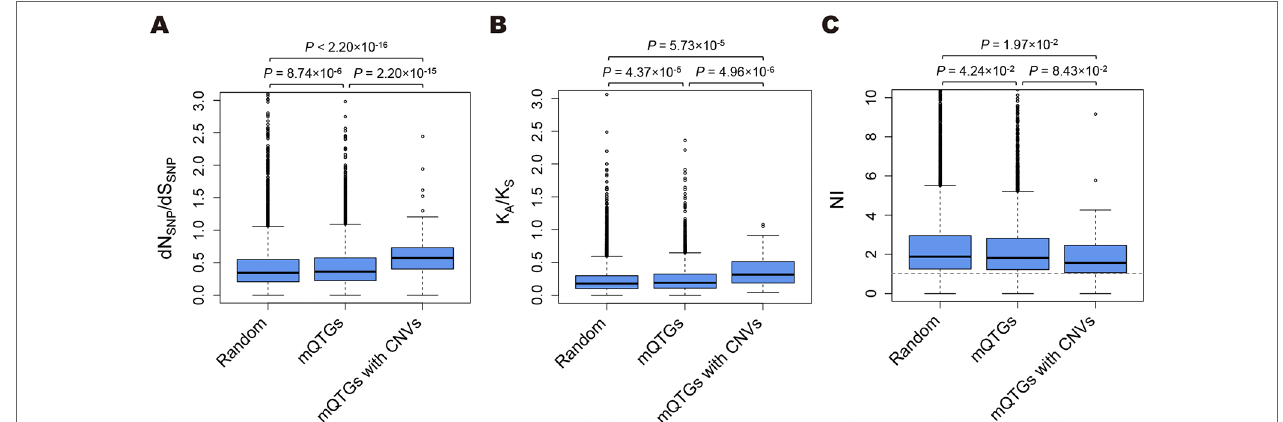
FIGURe 1 | Comparison of the functional divergence and the selection pressure in Arabidopsis . (A) Box plots present the dN SNP /dS SNP ratios of Arabidopsis thaliana accessions. (B) Box plots present the K A /K S ratios between A . thaliana and Arabidopsis lyrata . (C) Box plots present the NIs between A . thaliana and A . lyrata . Random, 10,000 randomly selected genes; mQTGs, metabolic quantitative trait genes; mQTGs with CNVs, metabolic quantitative trait genes with copy number variants. In each box plot, the box represents the 25%–75% range, the middle line represents the median, the dotted line represents the 1%–99% range, and the outer circles are outliers. P values were calculated with the Wilcoxon rank sum test. The horizontal dotted line represents NI = 1.0.